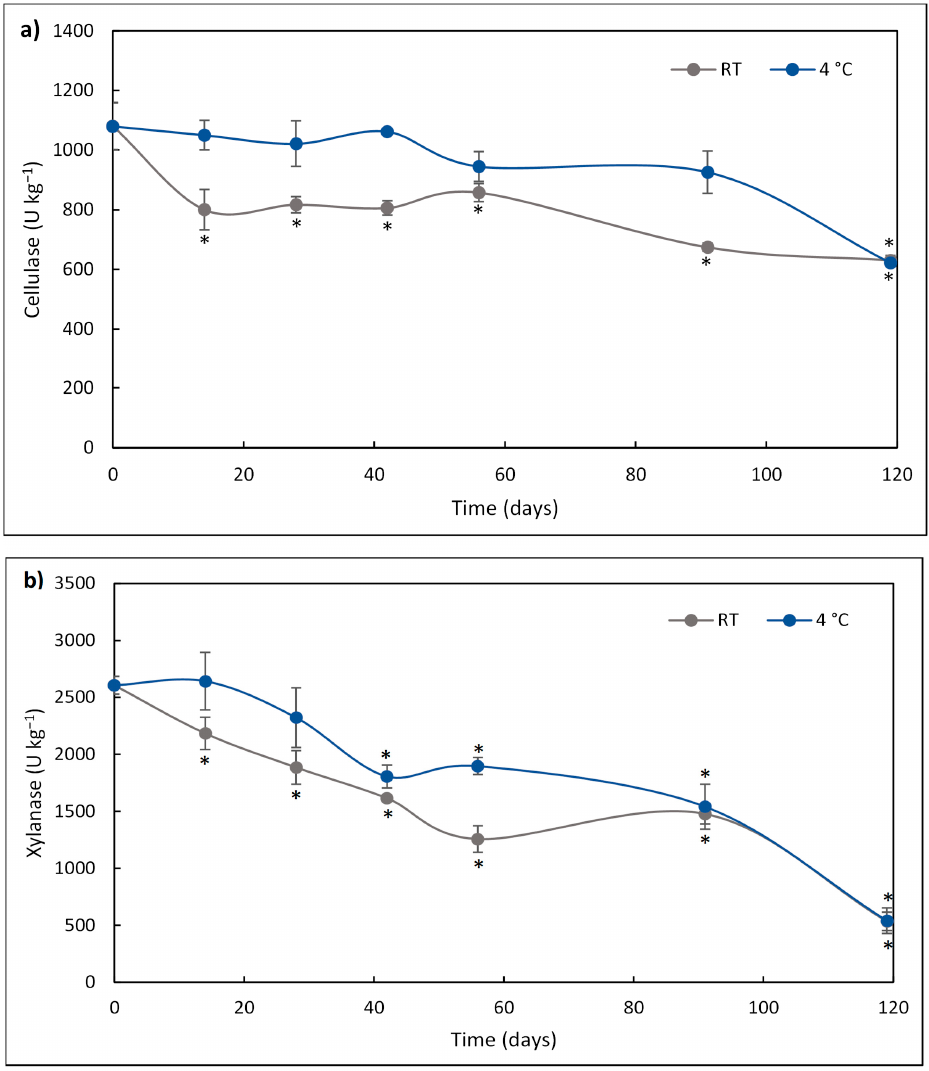
Figure 1. Cellulase ( a ) activity of FBE-supplemented diet over storage time (days) at room temperature (RT; square) and 4 °C (circles). The results represent the average of three independent experiments, and the error bars represent SD. The asterisk denotes a significant difference ( p < 0.05) from the initial enzyme activity. Xylanase ( b ) activity of FBE-supplemented diet over storage time (days) at room temperature (RT; square) and 4 °C (circles). The results represent the average of three independent experiments, and the error bars represent SD. The asterisk denotes a significant difference ( p < 0.05) from the initial enzyme activity.